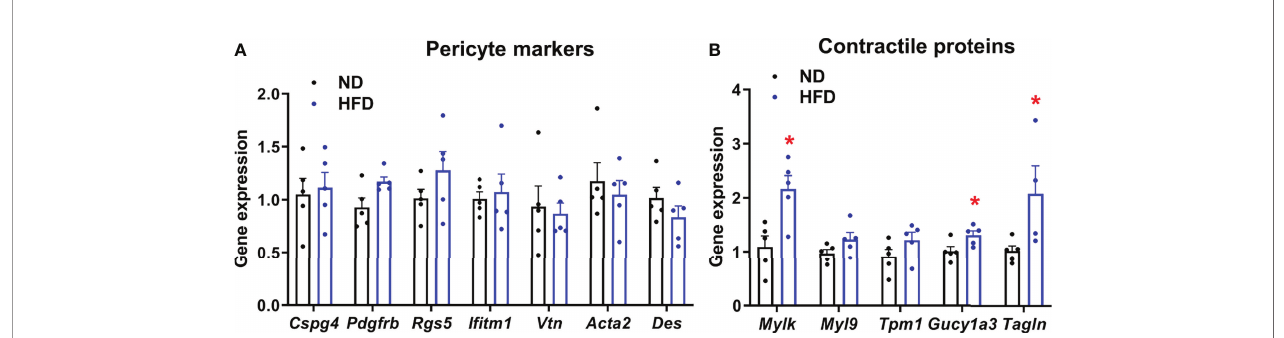
FIGURE 4 | Expression of pericyte and contractile markers in islets from normal diet (ND) and high-fat diet (HFD) fed mice measured by RT-qPCR. Gene expression was measured on islets isolated from 4-5 separate mice/group. Results were normalized by the geometric mean of Ppia, Aldo3, Mrlp32 and Tbp. Ct values and expressed as fold increase relative to ND-fed control. (A) Expression of pericyte markers in islets from normal diet (ND) and high-fat diet (HFD) fed mice measured by RT-qPCR. No signi fi cant change in expression was detected. Data is presented as mean ± SEM (n=4-5 separate mice/group, Mann-Whitney). (B) Gene expression pro fi le of contractile protein markers in islets from normal diet (ND) and high-fat diet (HFD) fed mice measured by RT-qPCR. Data is presented as mean ± SEM (n = 4-5 separate mice/group, Mann-Whitney). *P